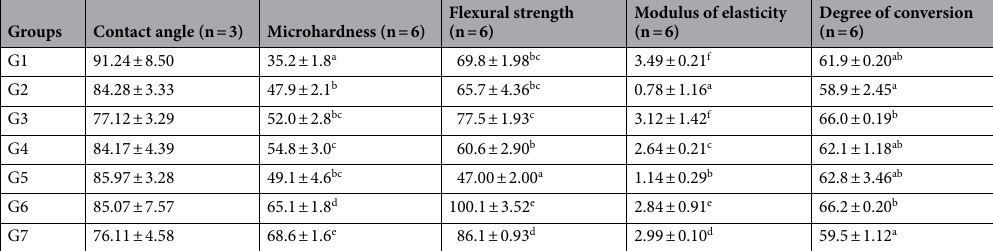
Figure 7 indicates the dispersion of the hybrid material in the GO nanosheets. Areas of medium transparency indicate overlapping of a greater number of layers 30 . The TEM micrographs in Fig. 7a, b show an interaction between MMt and GO, with a separation of the GO lamellar particles present in the hybrid. The points (G and H) demonstrate the morphology of the GO nanosheets and lamellar MMt nanoparticles. In Fig. 7c, it is also possible to observe a greater thickness of the hybrid of 178.12 nm, demonstrating the connection of the GO and MMt functional groups, which makes the nanoparticle thicker (Fig. 7c, d). Synthesis of the experimental RBCs.